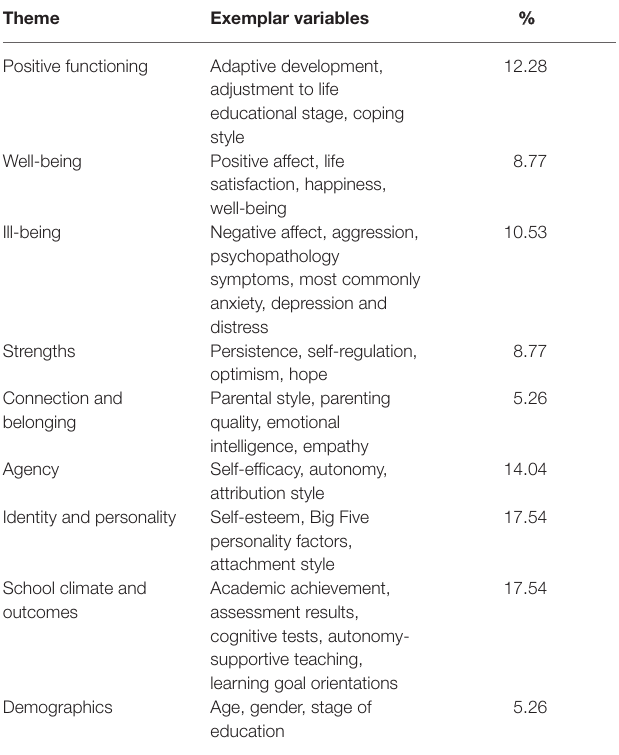
TABLE 6 | Thematic categories studied in quantitative positive education research.